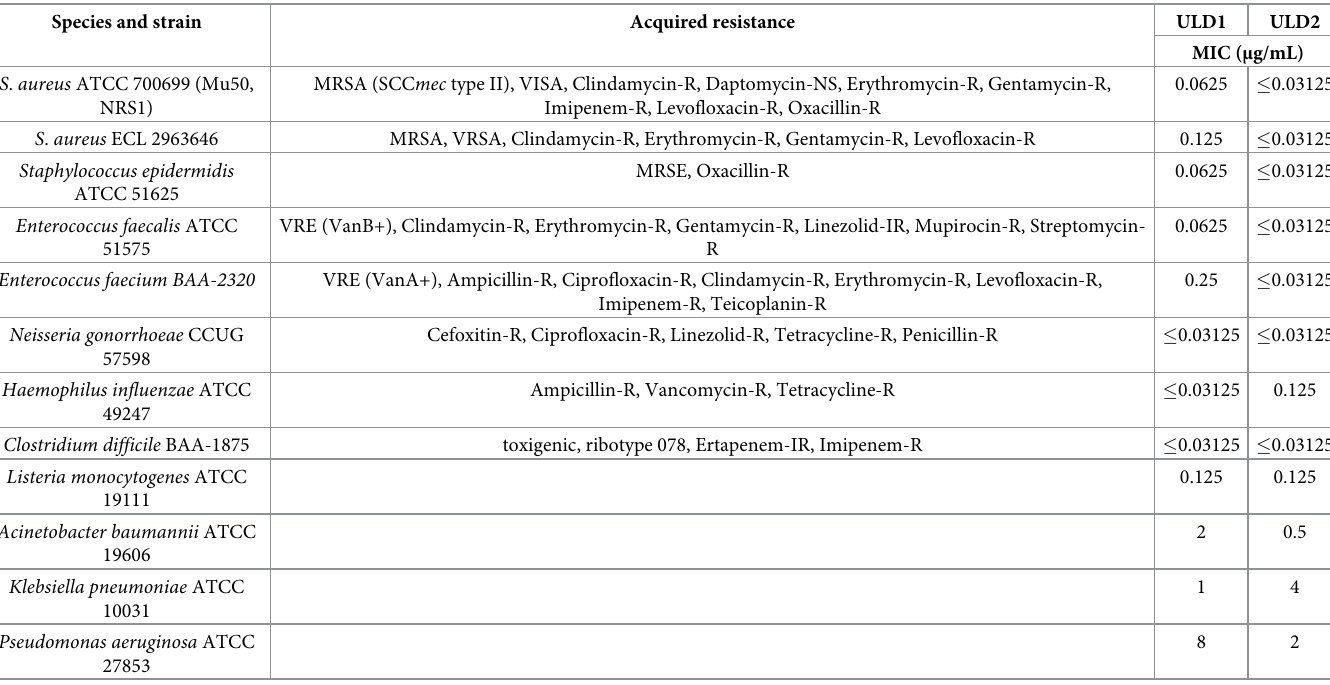
Table 2. Antimicrobial activities of ULD1 and ULD2 against selected pathogenic bacteria. Species and